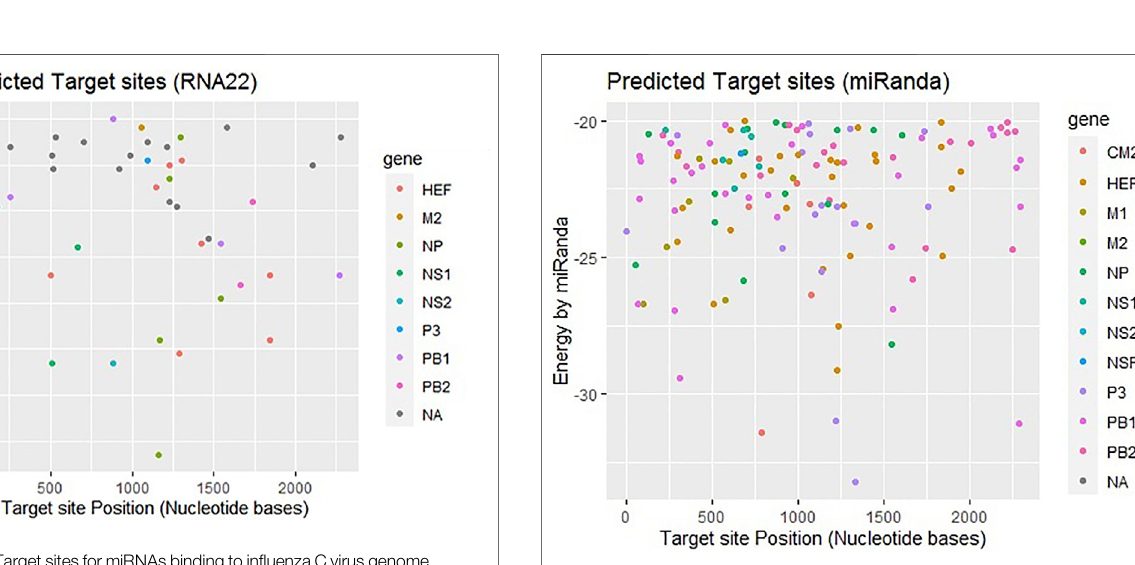
FIGURE 2 | In fl uenza C virus genome. Prediction of new target-sites for miRNAs in in fl uenza C virus.